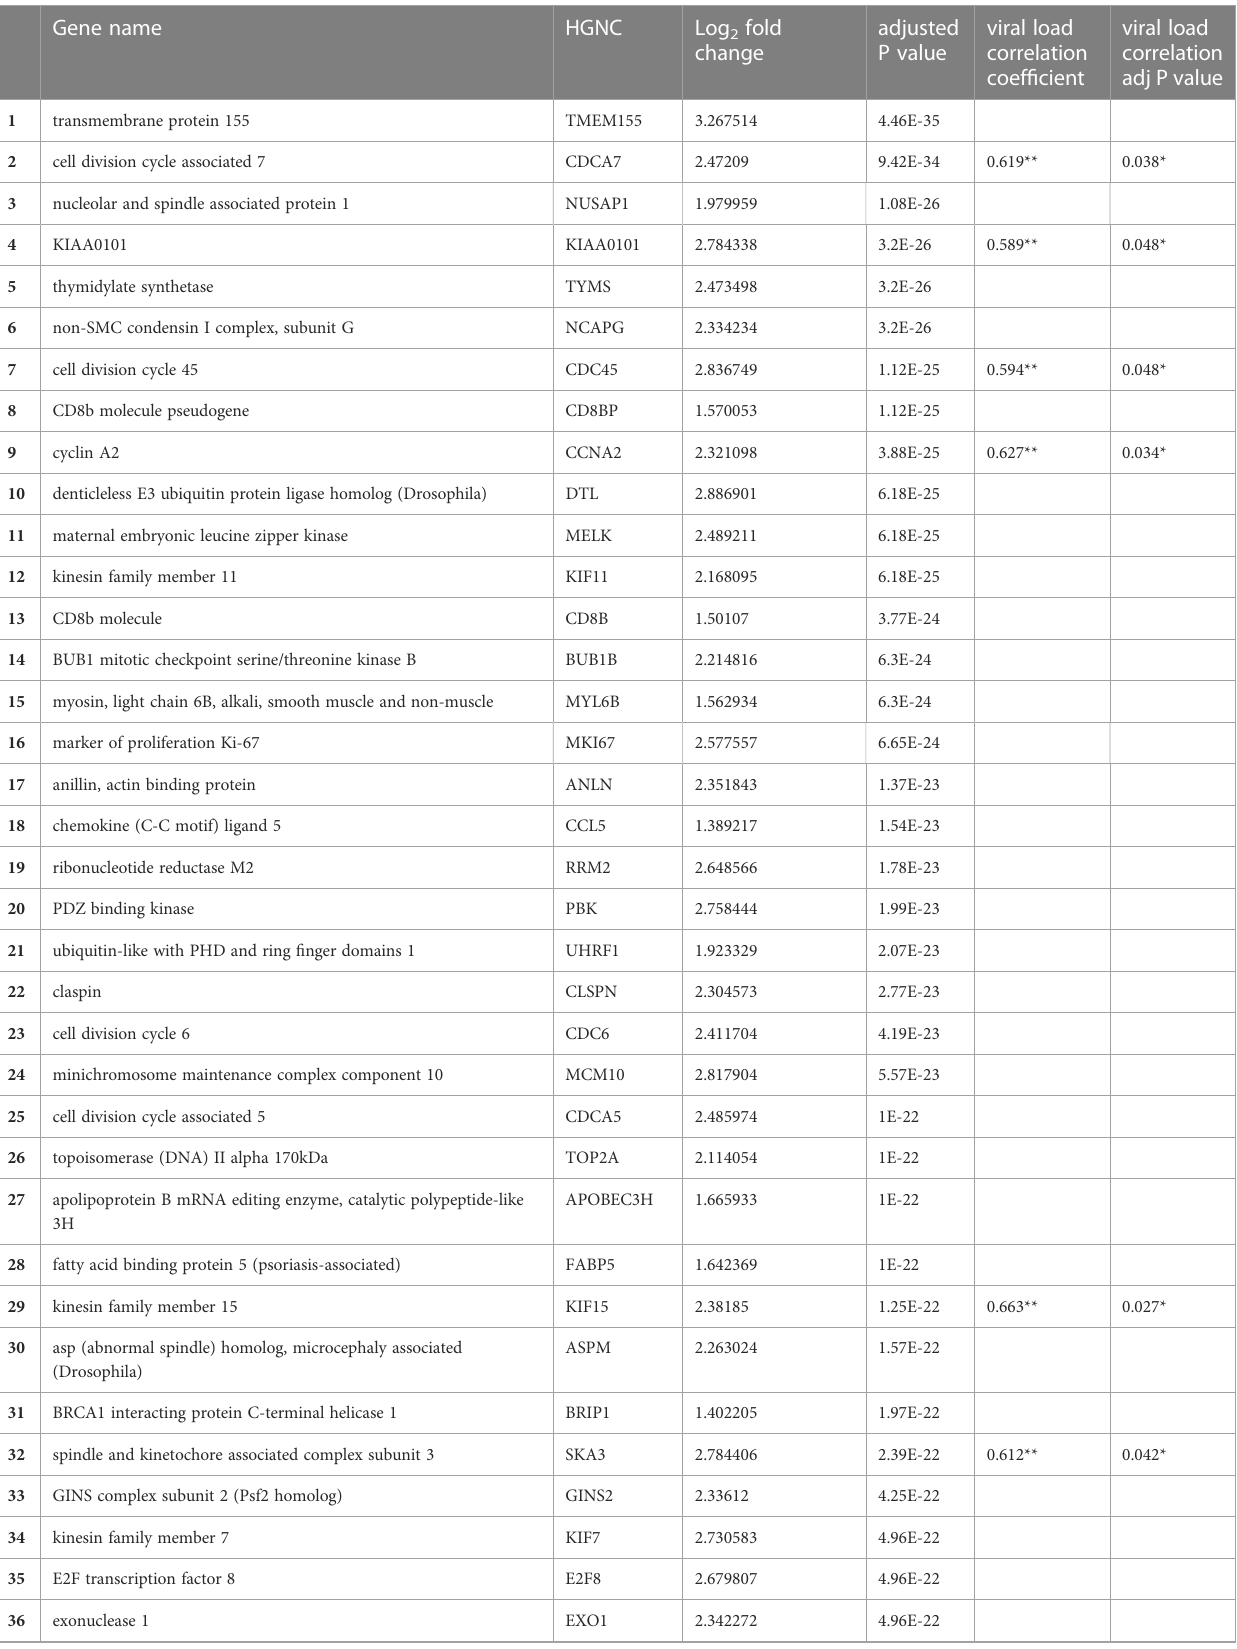
TABLE 2 The top 50 genes differentially expressed during acute HIV infection, eight of which were positively correlated with viral